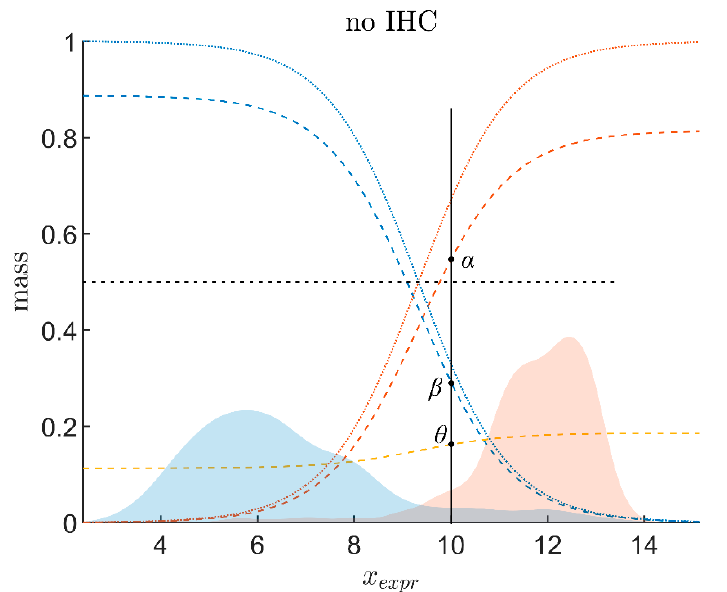
Figure 2. Logistic regression to obtain responsibility functions for decision theory evidence (data for estrogen, gene ESR1). Red-shaded area: distribution of gene expression for receptor positive (ac- cording to IHC) computed from density kernel estimates [71–73]. Blue shaded area: gene expression for negative IHC. IHC receptor status (IHC + 1, IHC − 0 ) was subjected to logistic regression versus gene expression ( x Expr ). Responsibility functions for receptor positivity, r + , (dotted red curve) and r − (dotted blue) were thus obtained. It will be shown later (Equation (4)) that r + has to be multiplied by an upper limit, ˆ α Expr , to obtain the actual belief α Expr , see the dashed red curve. Likewise for β Expr (dashed blue). Uncertainty: ochre. For a given expression value, e.g., x Expr = 10 , one can read off belief in positive ( α ), belief in negative ( β ) and uncertainty ( θ ). Note that analog concepts apply to any other gene of the full model.